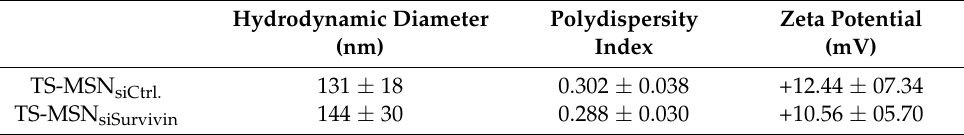
Figure 2. Representative size ( A , B ) and zeta potential ( C , D ) distribution for TS-MSN siCtrl ( A , C ) and TS-MSN siSurvivin ( B , D ). Mean values and SD are presented in Table 3. Table 3. Physicochemical characteristics of TS-MSN with control and anti-Survivin siRNAs.